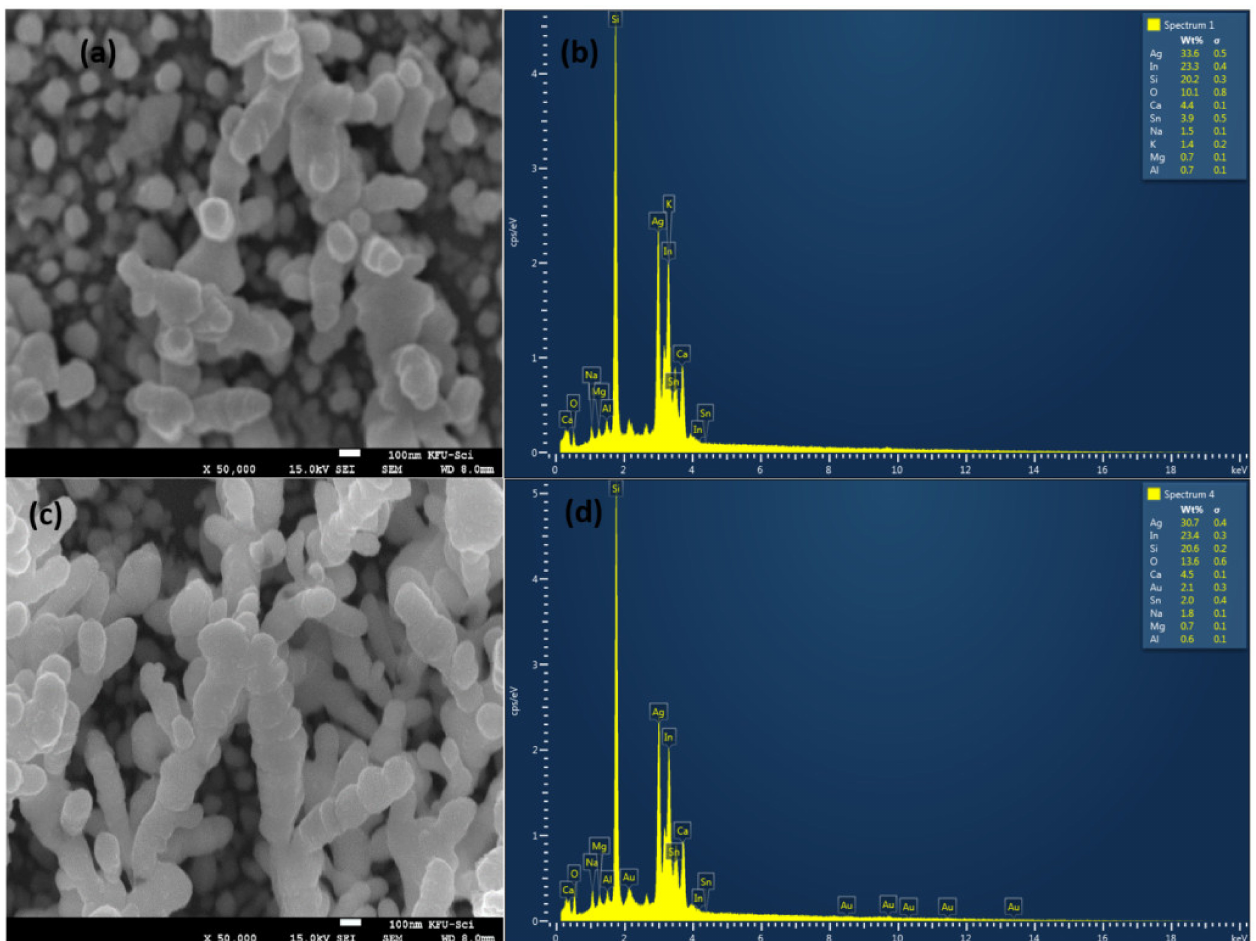
Figure 2. SEM images and EDX spectra of pure silver nanoparticles and silver/gold nanoparticles covering silicon nanorods. ( a ) SEM on silver with a magnification of × 50,000. ( b ) EDX on silver ( c ) SEM on silver/gold with a magnification of × 50,000. ( d ) EDX spectra on